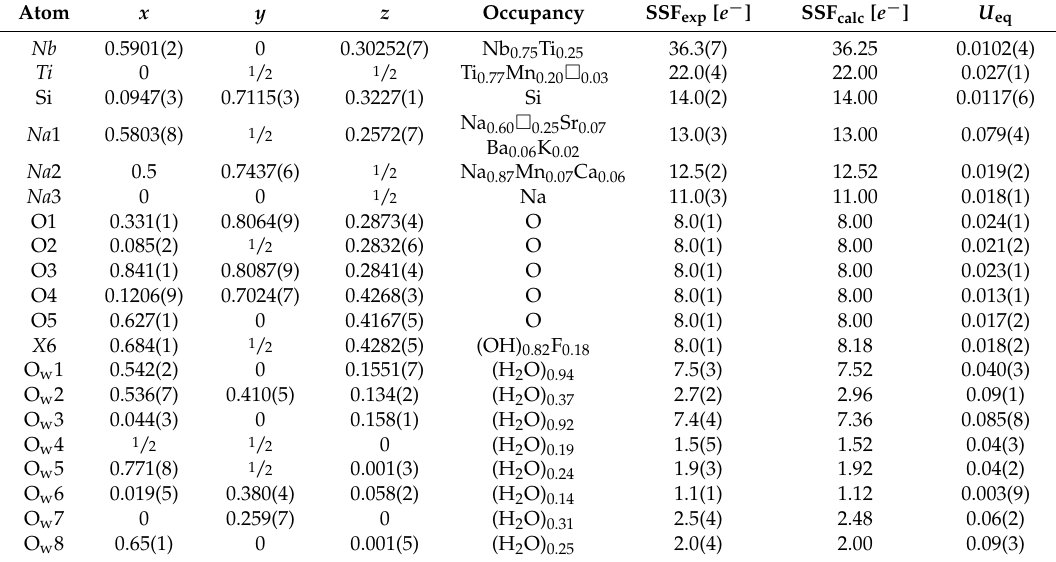
Table 3. Atomic coordinates, experimental and calculated site-scattering factors (SSF exp and SSF calc , respectively) and isotropic displacement parameters (Å 2 ) for